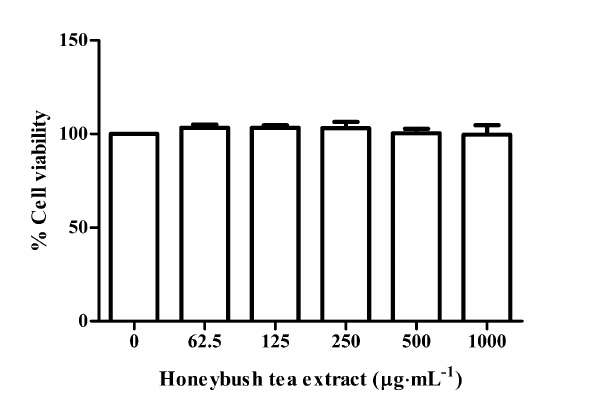
Figure 1. Effect of honeybush tea extract on cell viability. Cells were exposed to honeybush tea extract at increasing concentrations for 48 h. Data are expressed as the mean ±SD percentage relative to the control and are representative of three independent experiments conducted